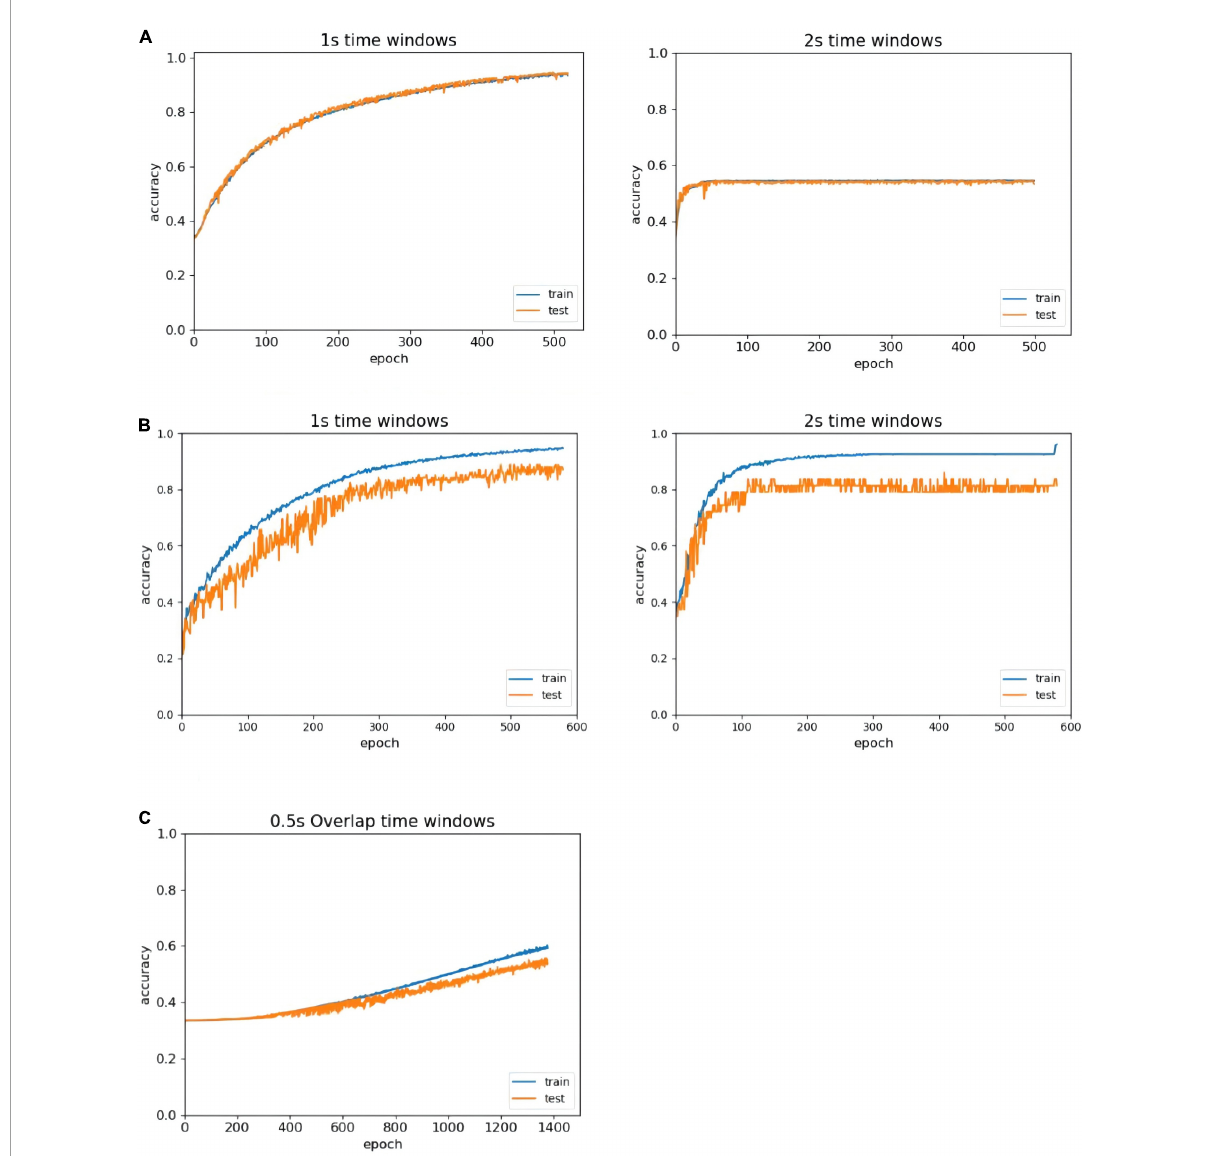
FIGURE5 Accuracy comparison of different time window lengths. (A) Comparison of different time windows in the DEAP without overlapped time window. (B) Comparison of different time windows in the SEED-IV without overlapped time window. (C) The recognition of overlapped window in the DEAP.